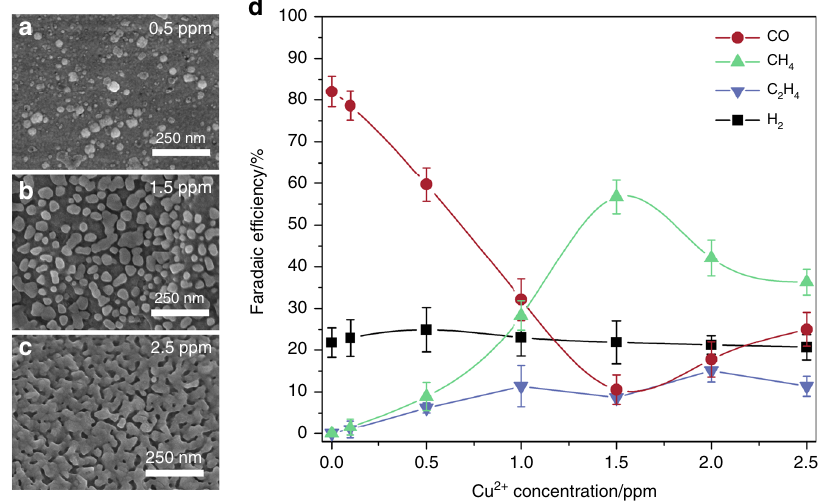
Fig. 3 Silver – copper model catalyst surface with different copper coverages. Scanning electron microscopic images of Ag-Cu surfaces achieved at Cu 2 + concentrations of 0.5 ppm ( a ), 1.5 ppm ( b ) and 2.5 ppm ( c ). d Faradaic ef fi ciencies of Ag-Cu surfaces with different Cu coverages for CO 2 electrolysis at − 1.10 V RHE . The error bars represent the standard deviation from at least three independent measurements